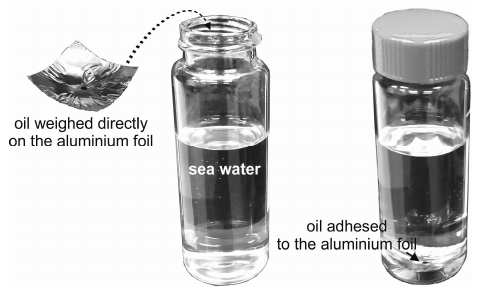
Figure 1. Procedure of the seawater sample exposure to oil.